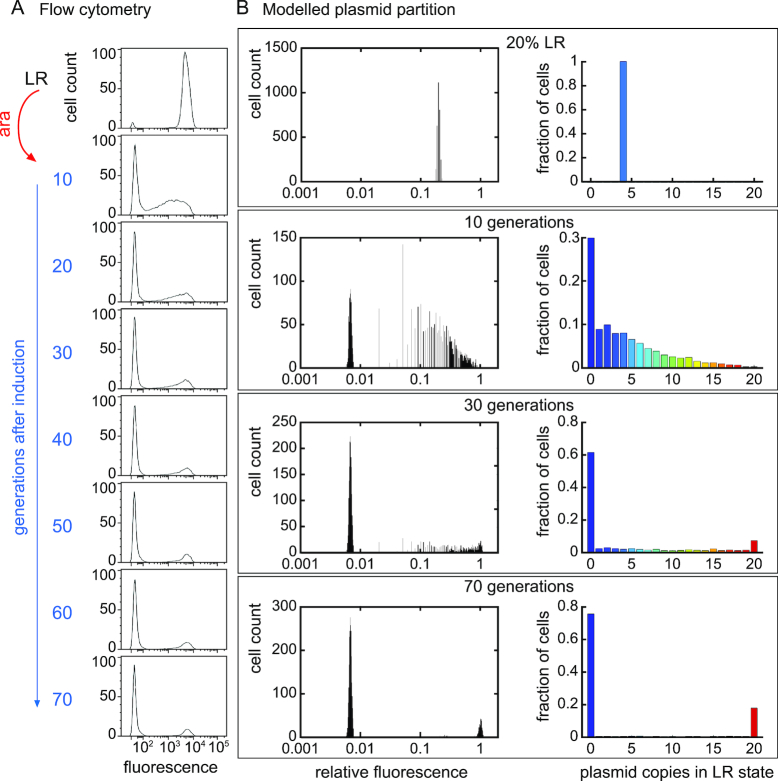
Segregation of pSWITCH3* in PB and LR states. (A) Cells containing pBAD-INT and pSWITCH3* in the LR state were subjected to a pulse of arabinose to induce switching to the PB state. Cells were diluted 1000-fold and then grown to stationary phase (10 generations) a total of seven times. At each stage, GFP fluorescence of ∼30 000 individual cells was measured by flow cytometry. (B and C) Stochastic simulation of cell fluorescence and plasmid segregation over 70 generations. The simulation was started with a population of 3000 cells, all with 16 PB plasmid copies and 4 LR copies (20% LR). In the model, plasmids replicate and then are randomly distributed between daughter cells at cell division. Each cell produces GFP at a rate proportional to the LR copy-number and inherits half the GFP content of its mother cell. The left panels show simulated flow cytometry plots at 0, 10, 30 and 70 generations. The number of cells in each fluorescence bin is plotted. Right panels show the distribution of LR copy-number in cells at 0, 10, 30 and 70 generations.